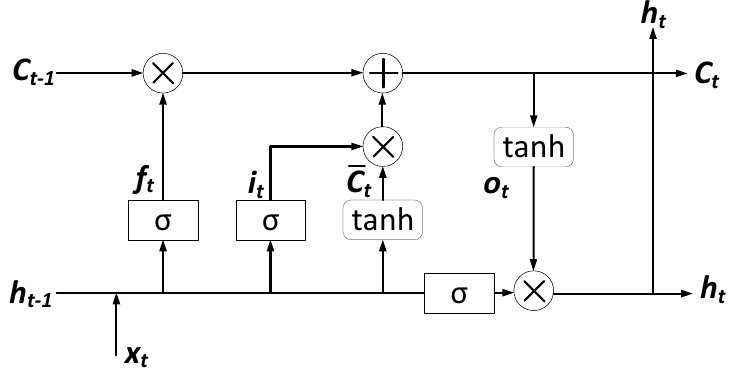
Figure 3. LSTM architecture. Figure 3. LSTM